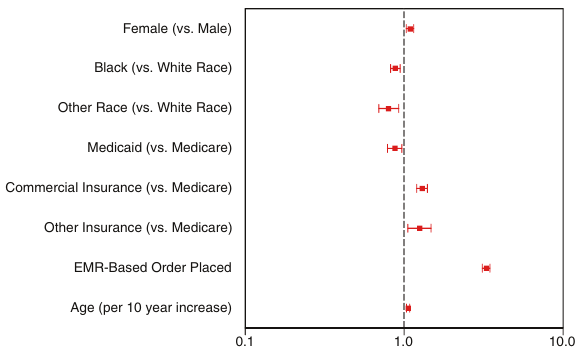
Fig. 2 Multivariable analysis of predictors of 90-day follow-up. Key demographic subgroups and their association with 90-day follow-up rates were analyzed using a multivariable logistic regres- sion model. The predictors of 90-day follow-up included female sex, commercial insurance and other insurance (which included self-pay, workers comp), and age (per 10-year increase). Age per